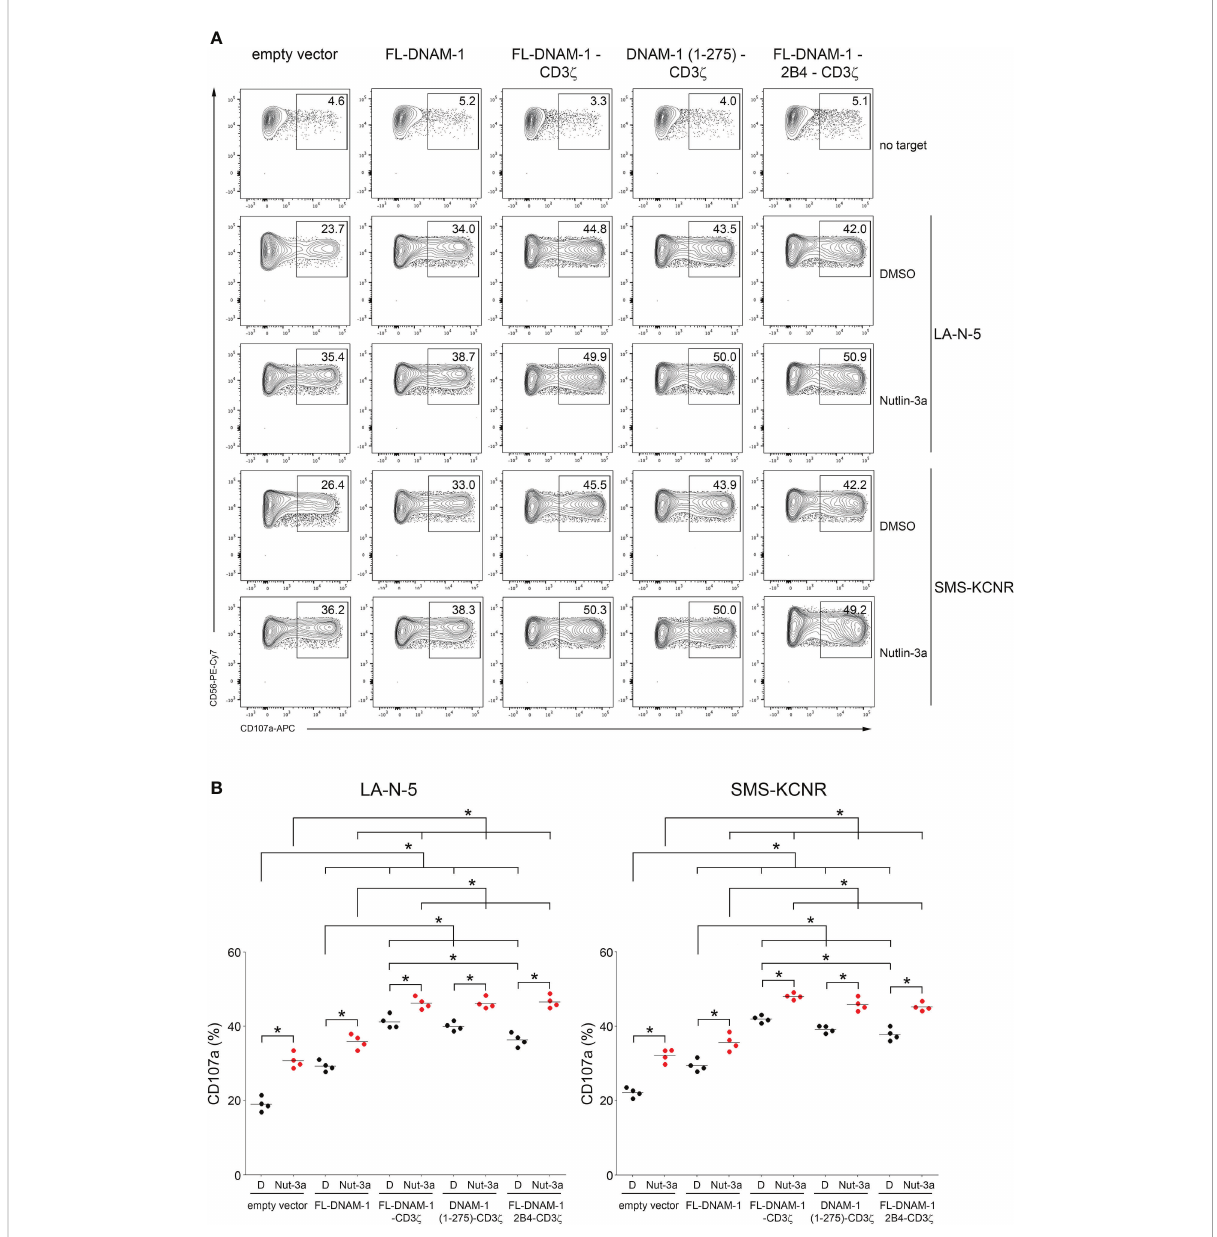
FIGURE 4 Nutlin-3a boosted the susceptibility of NB LA-N-5 and SMS-KCNR cells to DNAM-1-engineered NK cells. NB LA-N-5 and SMS-KCNR cell lines were left untreated (DMSO) or treated with Nutlin-3a at 2 m mol/L for 48 hours and used as targets for degranulation assay of DNAM-1- engineered NK cells. (A) Degranulation of NK cells, measured as CD107a expression upon stimulation with LA-N-5 or SMS-KCNR cells treated with DMSO or Nutlin-3a. The percentages of CD107a + DNAM-1-engineered NK cells are indicated in each plot. A representative experiment of four performed in NK cells isolated from independent healthy donors and transfected with DNAM-1-constructs is shown. (B) Summary of degranulation of NK cells isolated from four independent healthy donors and transfected with DNAM-1-constructs, in response to LA-N-5 or SMS-KCNR cells treated with DMSO (D) or Nutlin-3a (Nut-3a). Dots correspond to the percentage of CD107a + NK cells from each healthy donor transfected with each indicated DNAM-1-based constructs; horizontal bars indicate the mean; * p <0.05; p value (two-tailed non- parametric Mann-Whitney